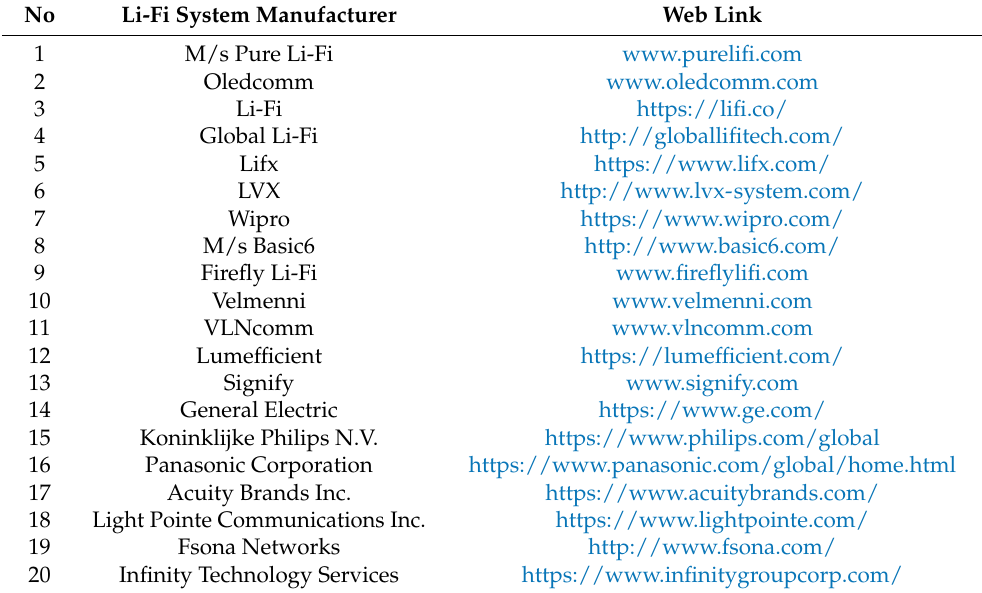
Table 1. List of Li-Fi system manufacturers (All accessed on 15 January